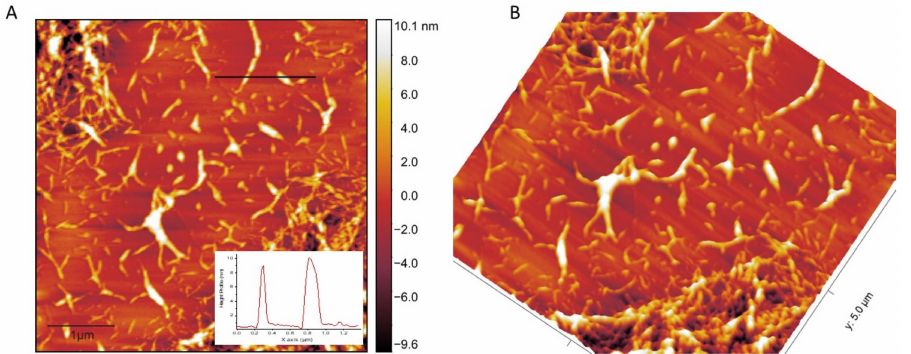
Figure 6. Atomic force microscopy of CNs ( A ) Z-height topography with height profile ( B ) 3D image collected from tapping